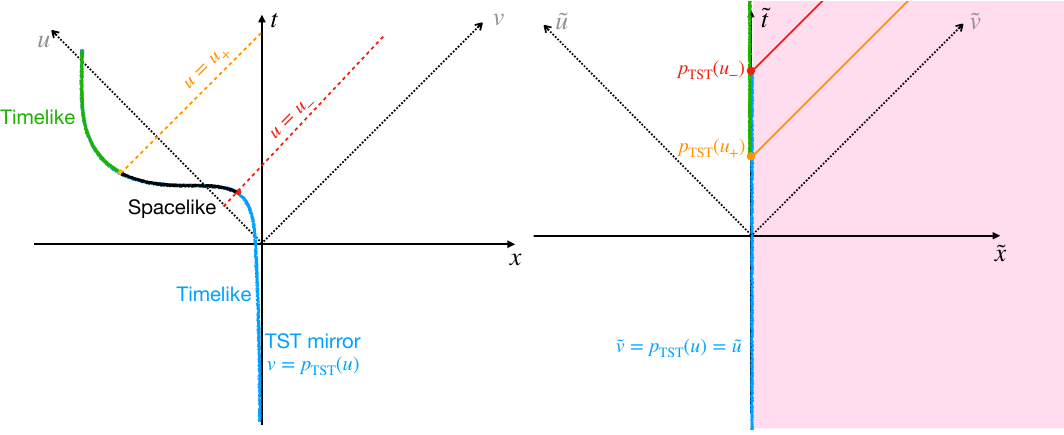
) ≈ (0 , u ) of the profile is always spacelike. Left: non-zero − , u + 0 ( u ) = 0 . ± TST